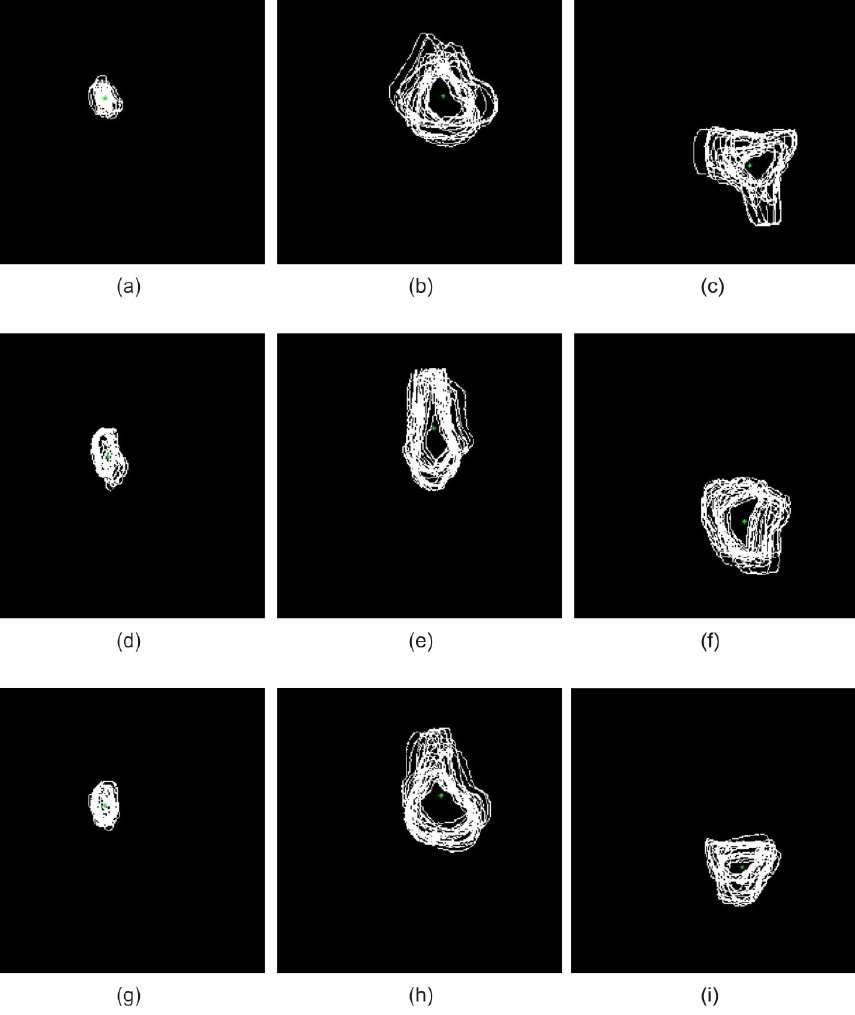
Figure 5. Superposition of selected 3rd ( a – c ), 6th ( d – f ), and 9th ( g – i ) set of the teaching group on the sagittal plane along with the centroid marked for the patella, femur, and tibia,